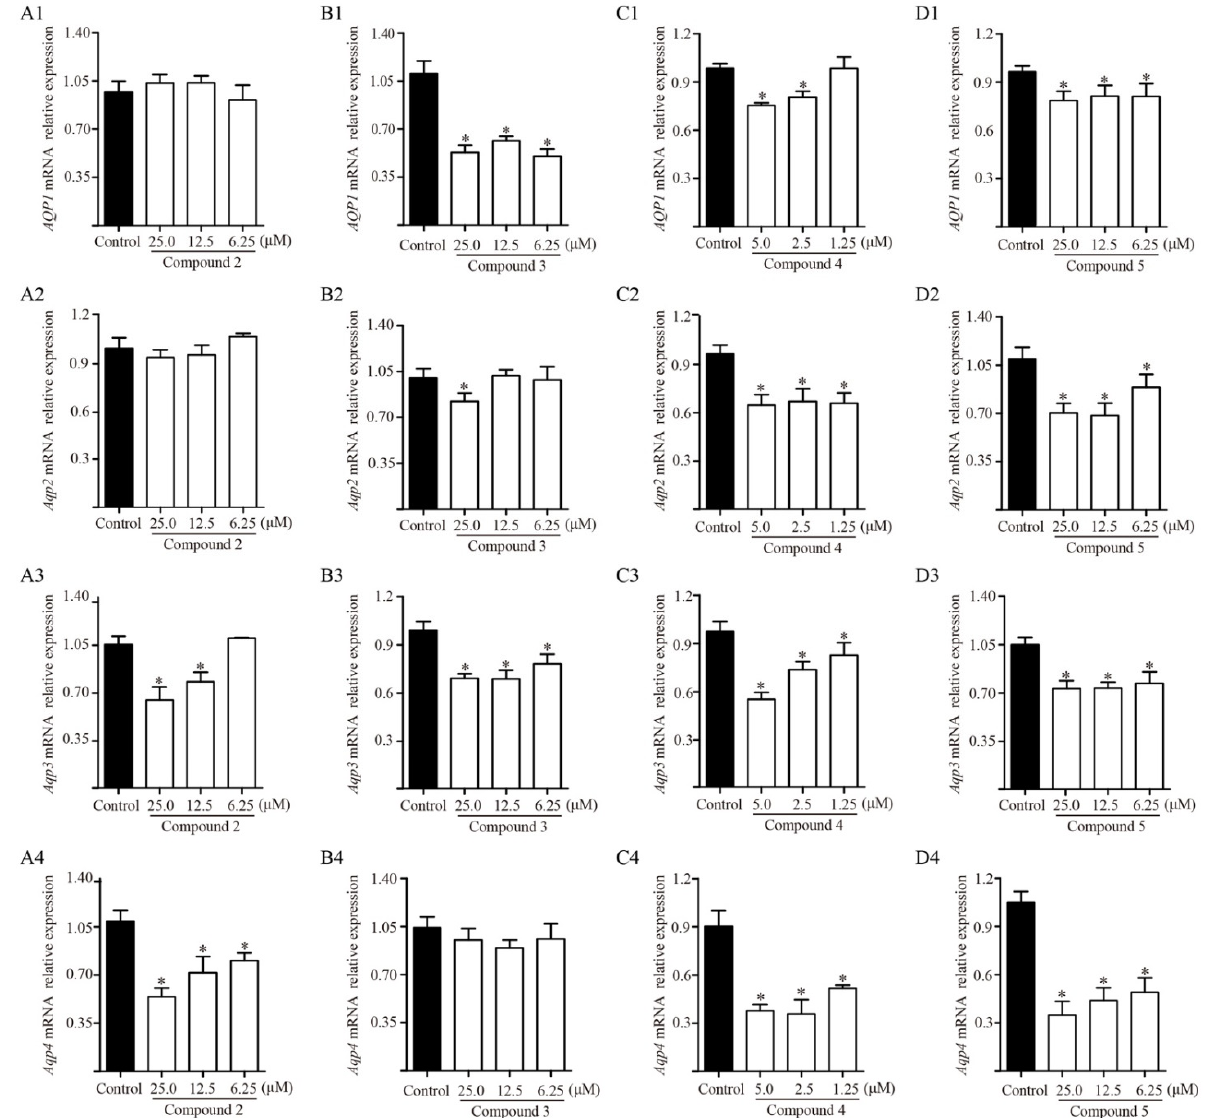
Figure 9. Effect of compounds 2 , 3 , 4 and 5 on mRNA expression levels of aquaporin ( AQP ) -1 in human kidney-2